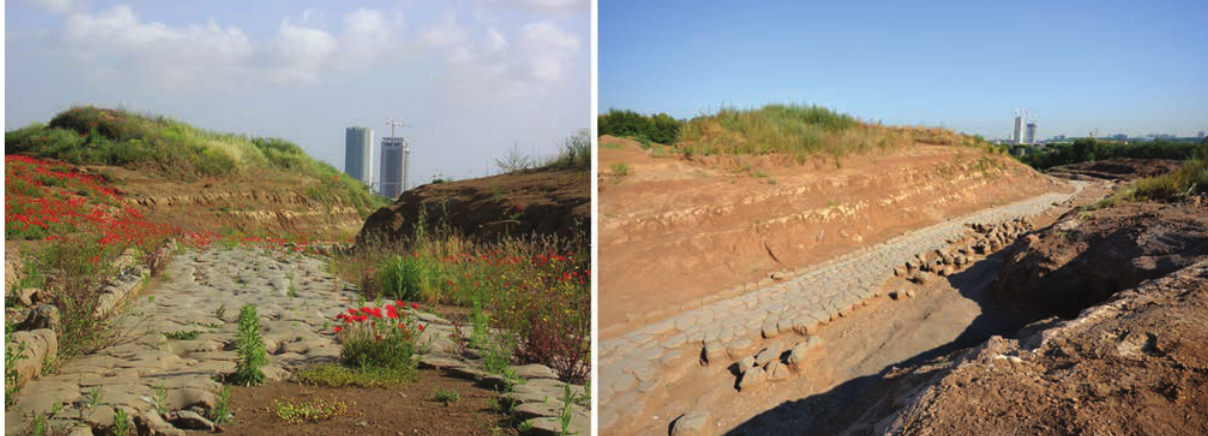
Figure 1. Views (from S) of the Via Laurentina road (mile 6). The two towers of the “Europarco Business Park” can be seen in the back-